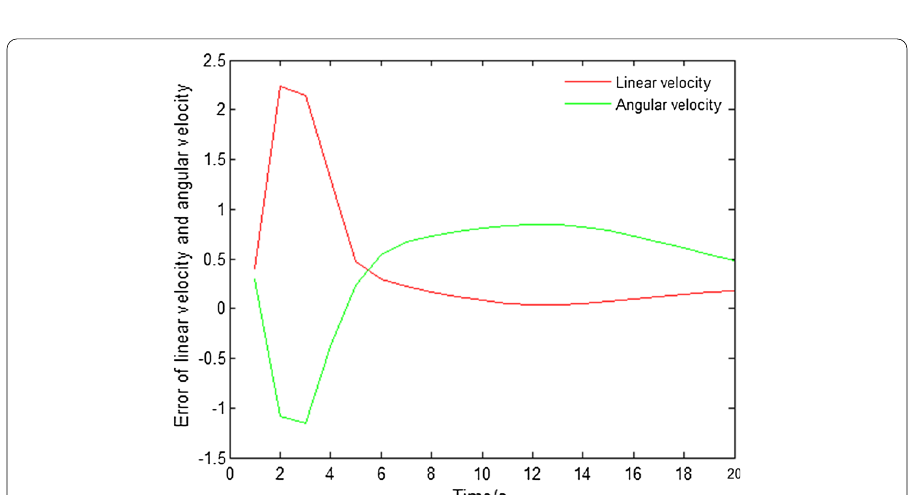
Fig. 8 Linear velocity and angular velocity diagram of circular